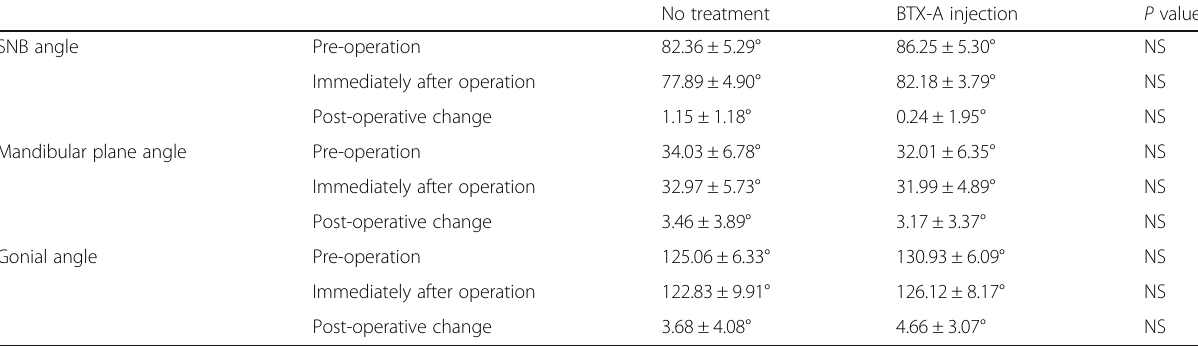
Table 2 Results of angular measurements